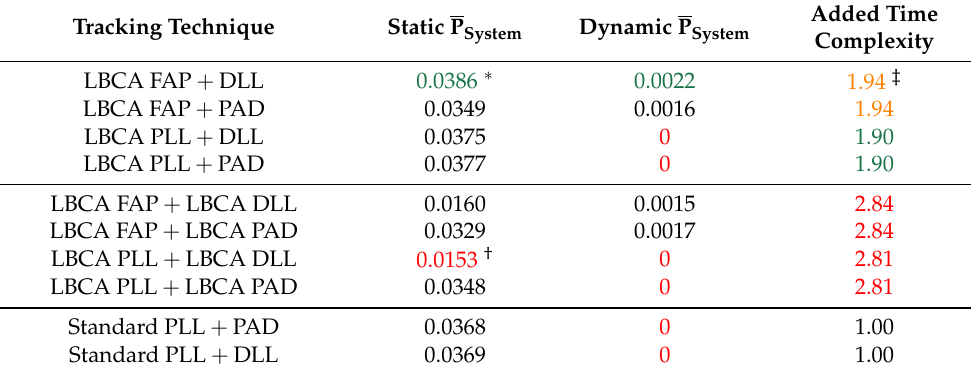
Table 4. System performance of adaptive tracking